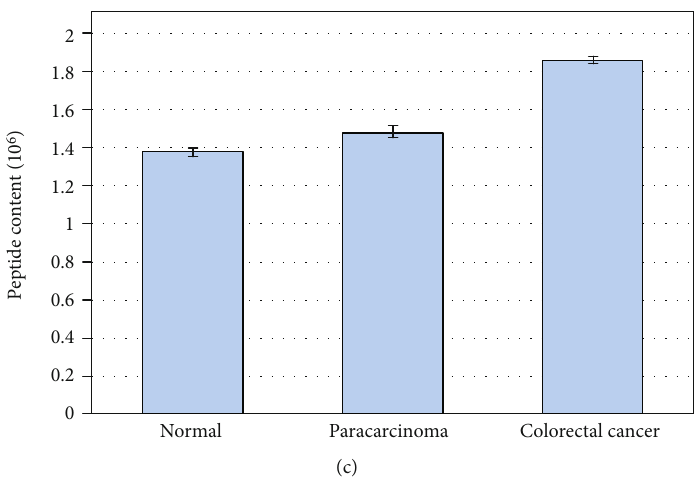
Figure 2: Identi fi cation of MSLN expression in colorectal cancer tissue by immunohistochemistry. MSLN was expressed 3% in pericancerous tissue (a) and 83% in colorectal cancer tissue (b). (c) Higher expression of MSLN was detected in colorectal cancer tissue than that in normal and pericancerous tissues by MRM method ð P < 0 : 01 Þ . Table 1: Quanti fi cation of MSLN protein.